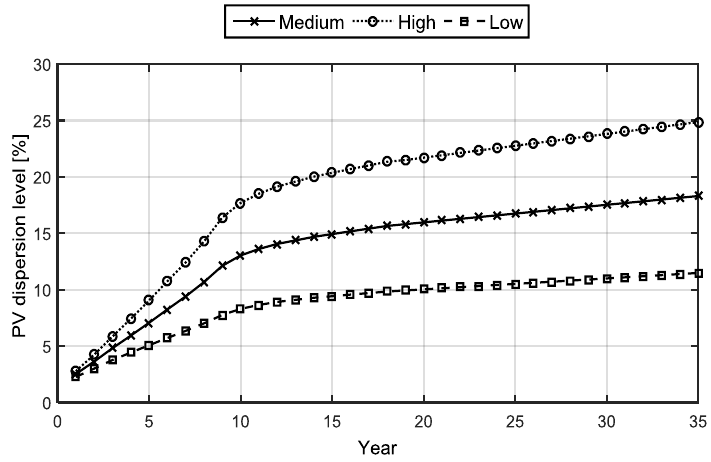
Figure 3. Forecast for residential PV by ENWL from 2014 (total dispersion in network).